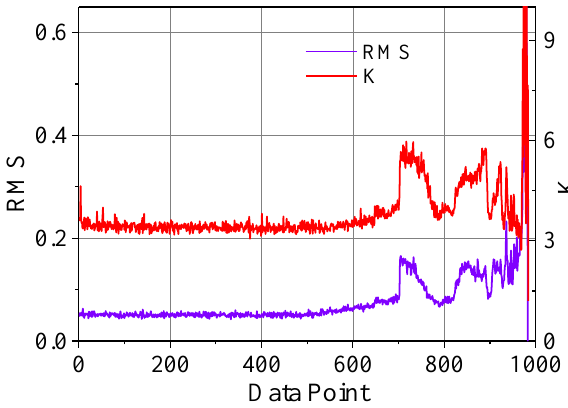
Figure 1. Root mean square (RMS) and kurtosis trend graph.